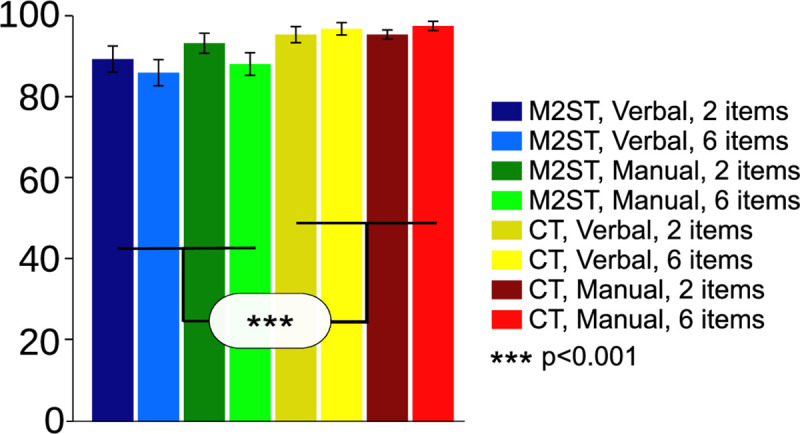
Task performance.Across-subject average hit-rates (% correct) in the manual and the verbal response modality and separately for each load (2 or 6 items) and for each task (M2ST and CT). Error bars denote standard error. Hit rates differed significantly between M2ST and CT (for detailed statistics, please refer to the Results section).